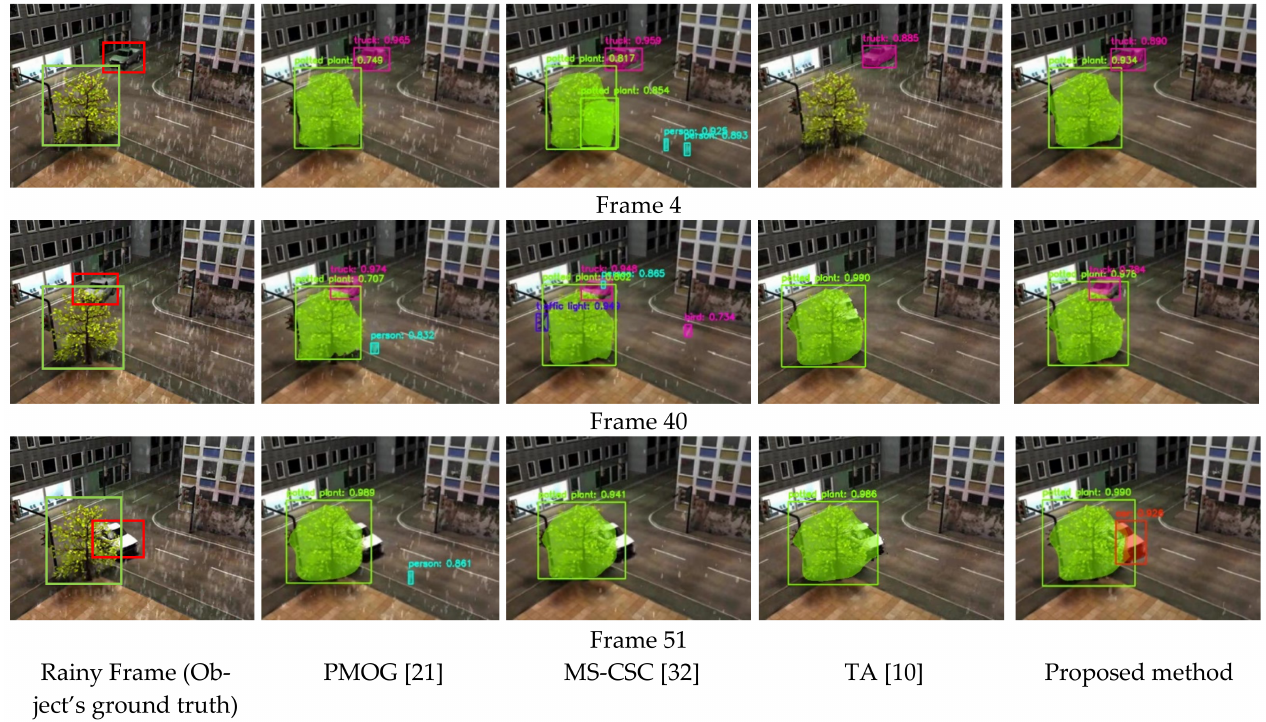
Figure 15. Comparative evaluation of rain-free video for different methods, using the object detection algorithm. Table 1 represents a comparative evaluation of the performance of the object detection algorithms on rain-free video from different methods in two different evaluation